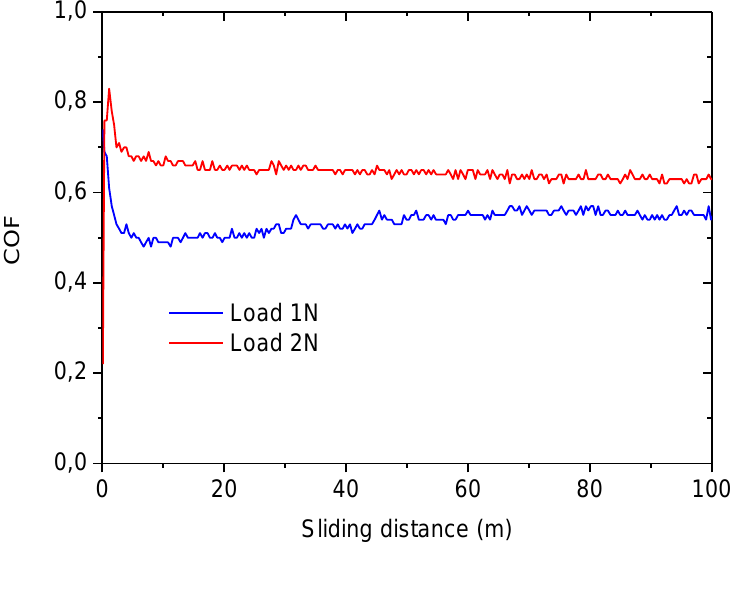
Figure 9. Friction coefficients, COF, for the glass-ceramic substrate against corundum counterbody with the sliding distance for loads of 1 and 2 N and sliding distance of 100